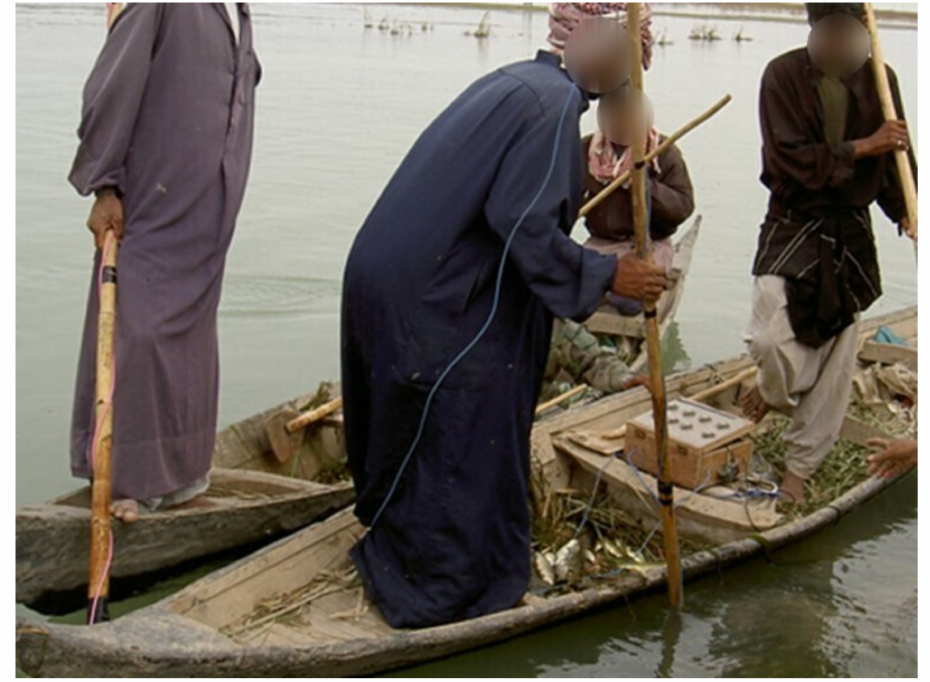
Figure 25. Electrofishing in restored Mesopotamian marshland often replaces more traditional meth- ods, and without sound management and community cooperation may threaten the sustainability of stocks. Source: Edward